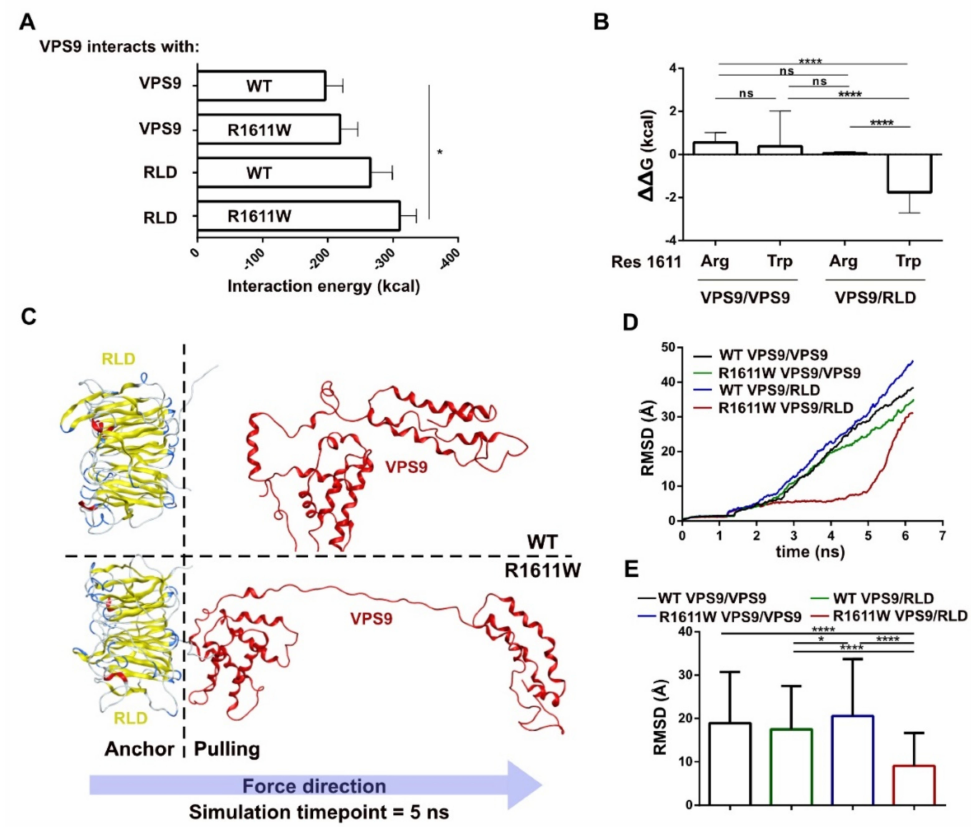
Figure 5. Dimers stability. ( A ) interaction energy calculated with AMBER. ( B ) ∆∆ G calculation for dimers involving mutants of residue 1611; statistics: one-way ANOVA ( C ) Representative snapshot of steered molecular dynamics at 5 ns showing interaction of WT VPS9 (top) and W1611 VPS9 (bottom) interacting with RLD when VPS9 residues are pulled. ( D ) XY plot representing RMSD of VPS9 core over time in SMD from ( C ). ( E ) Average RMSD of VPS9 core throughout SMD production simulation from ( C ); statistics: one-way ANOVA. p -value < 0.05 is *, p -value < 0.0001 is